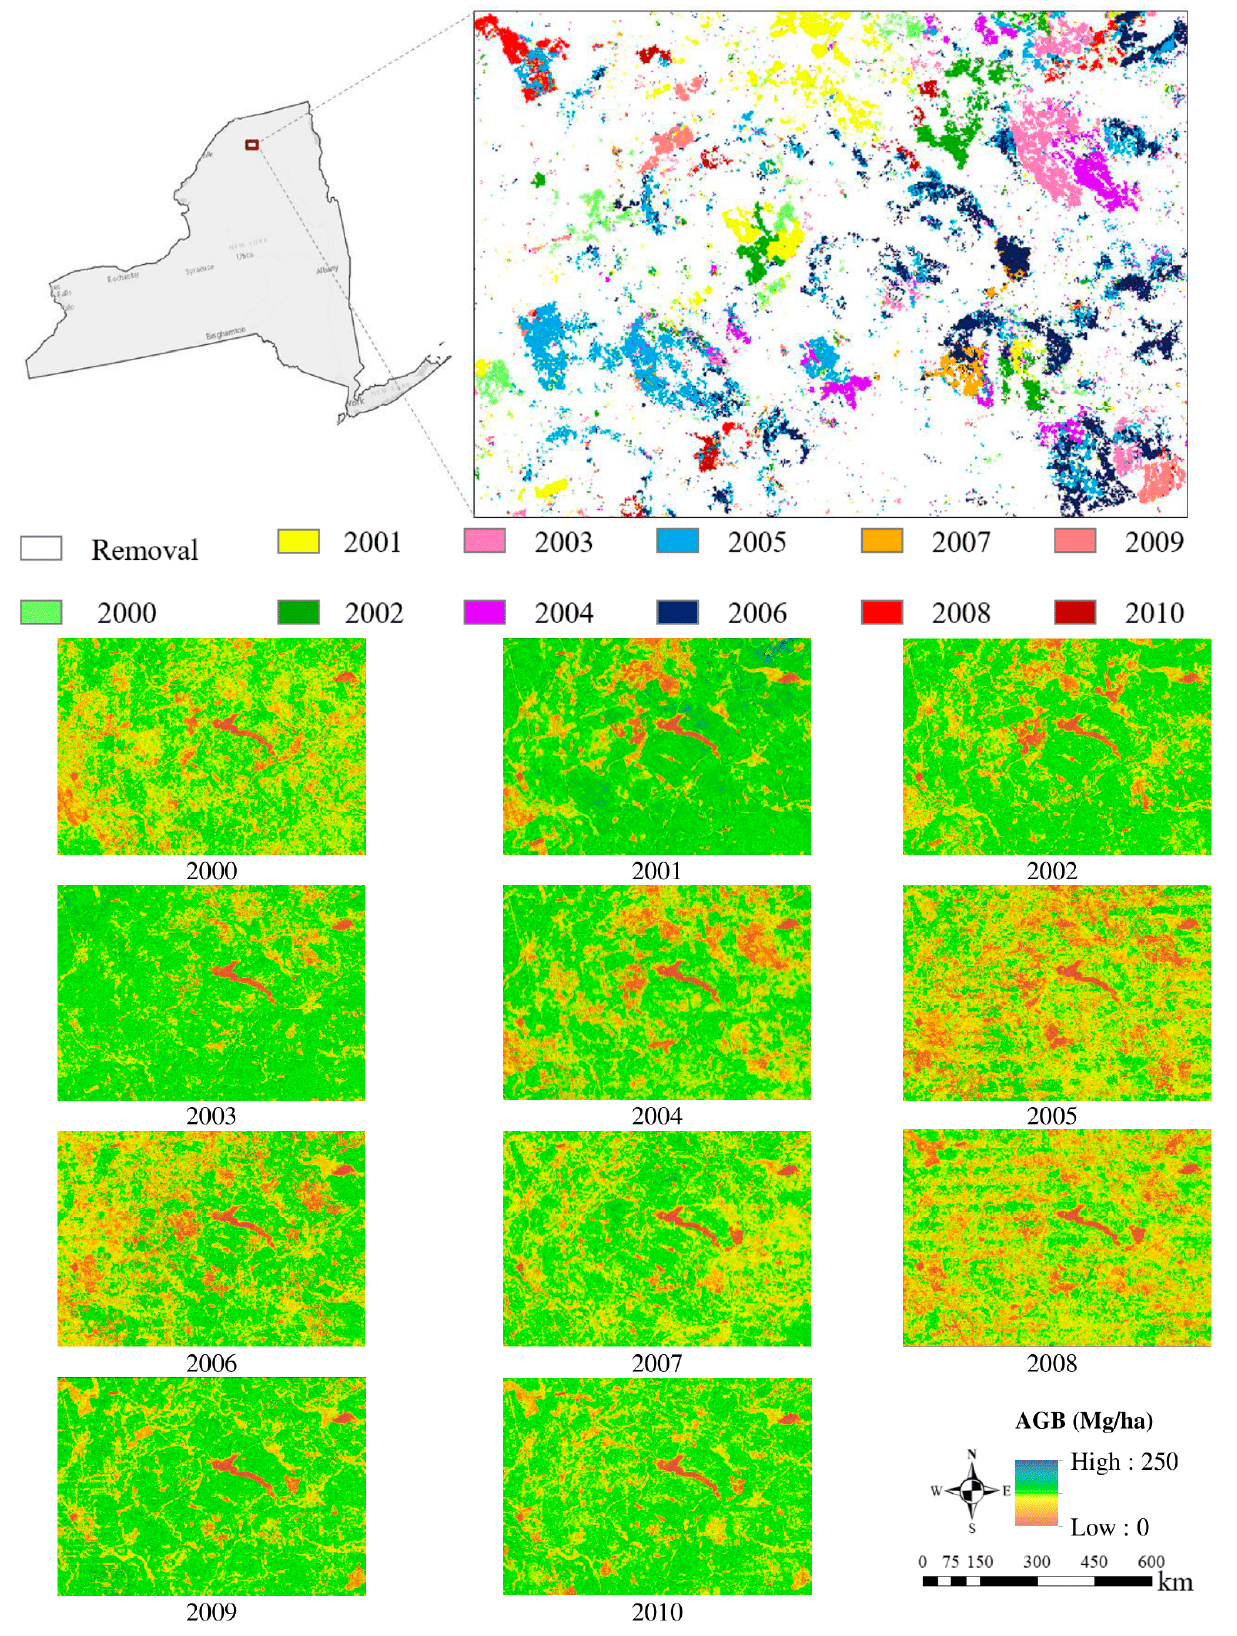
Figure 6. Forest change (removal) from 2000 to 2010 in an area in northern NYS and the related AGB maps.